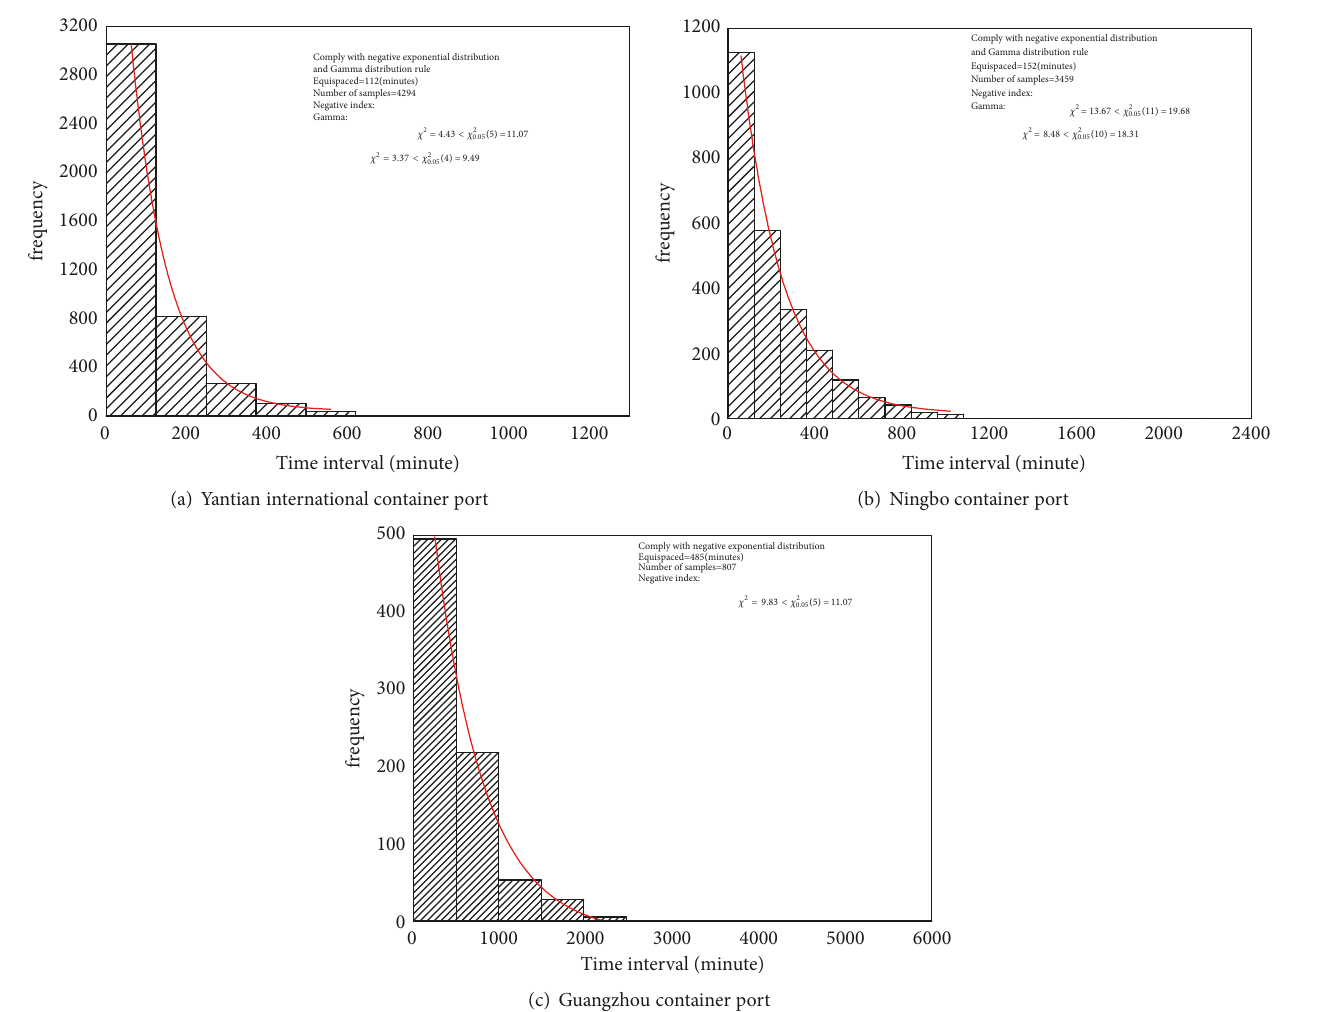
Figure 11: Distribution of the interarrival time of